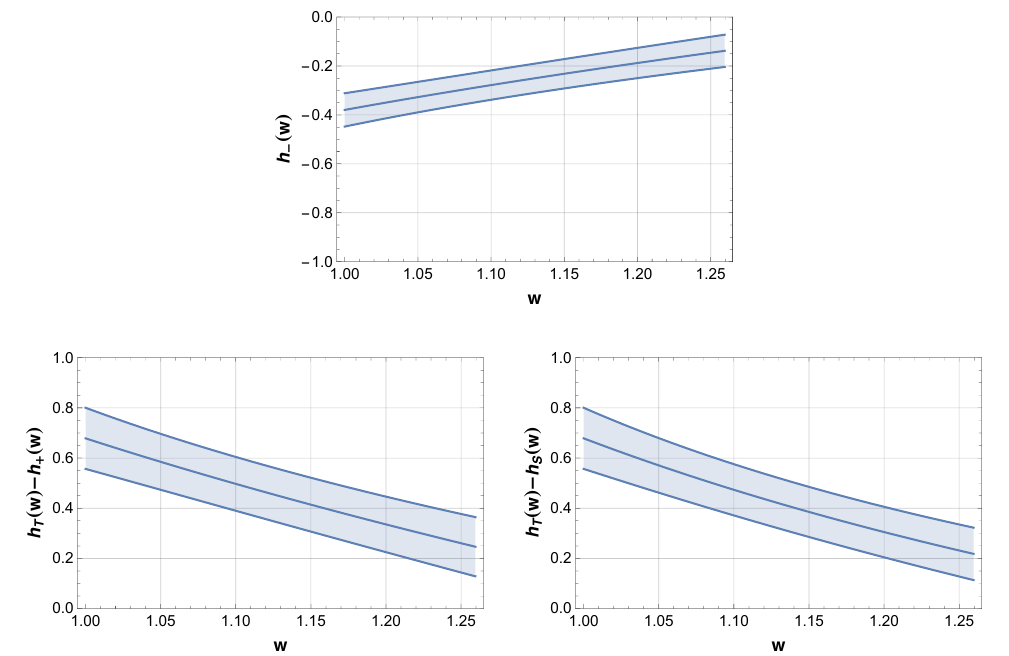
Figure 4 . B c → η c form factors in eqs. (5.14), (5.15) and (5.16) extended to the full kinematical range, obtained using lattice QCD results for V and A